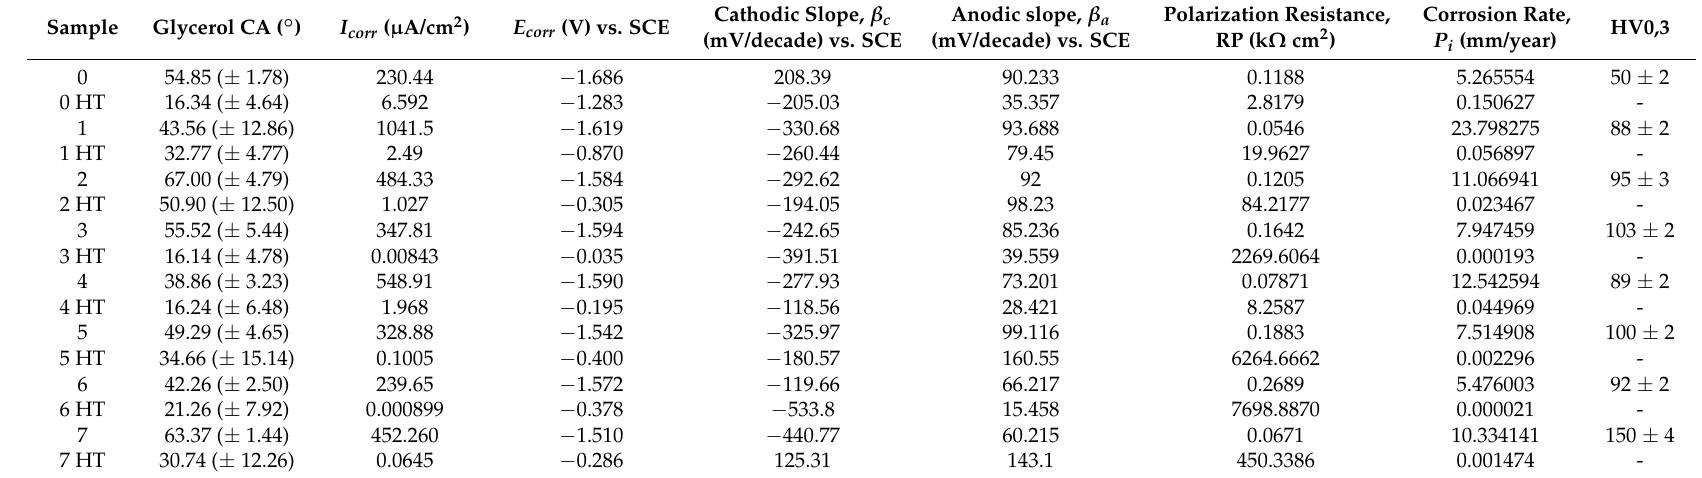
Table 1. Summarised properties of the base and hydrothermally treated (HT)